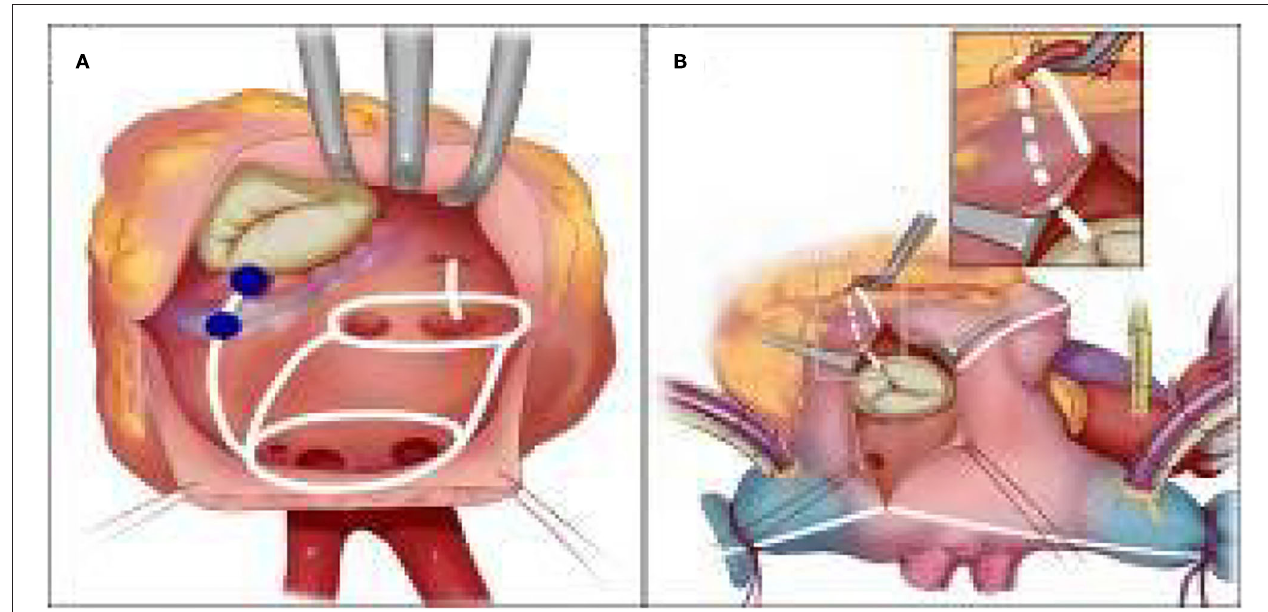
FIGURE 4 | (A) Left atrial lesion sets for Cox-maze IV procedure in the mirror-image dextrocardia, Mitral isthmus lesion is between the shaded color (light and dark blue) at the posterior mitral annulus and the coronary sinus. (B) Right atrial lesion sets for Cox-maze IV procedure in the mirror-image dextrocardia. The tricuspid annulus lesion is completed after dissecting the peripheral epicardial fat of the right coronary